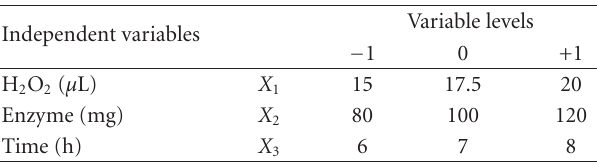
Table 1: Independent variables and their levels for D-optimal de- sign of the MEOA